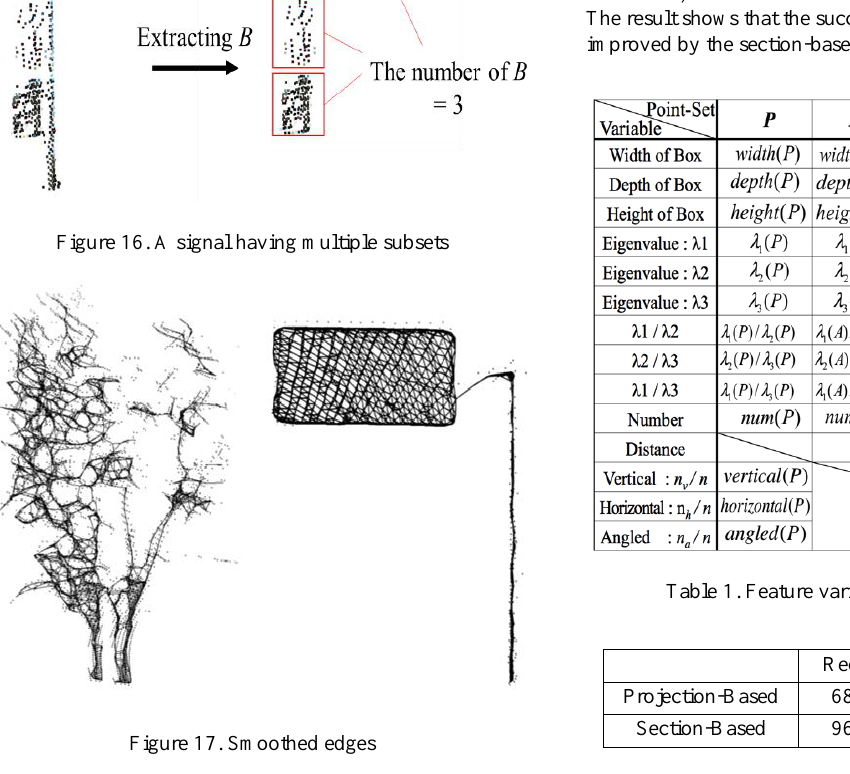
Table 2. Detection rates of pole-like